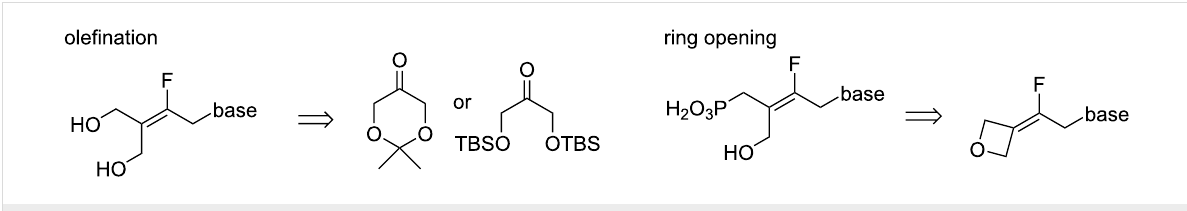
Figure 3: Olefination approaches and ring-opening of oxetane derivatives.